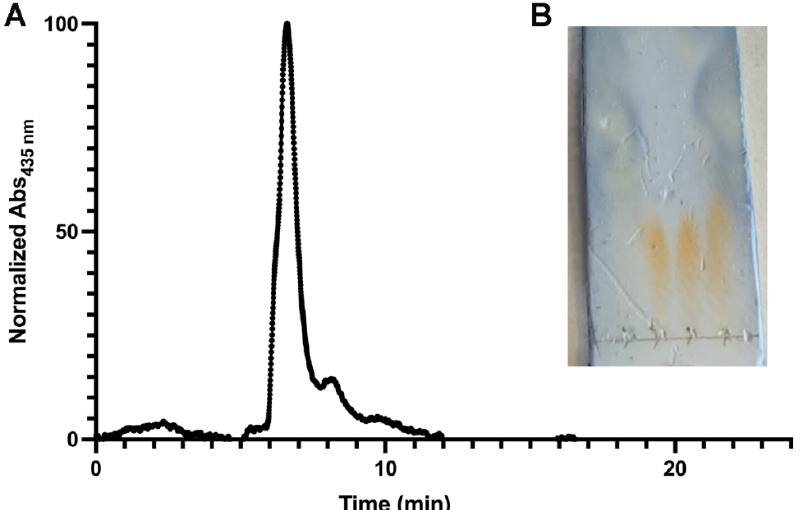
Figure 3. HSC lacks a chromophore, making chromatographic fractions hard to assay. ( A ) Chelation with Fe 3+ results in a chromophore absorbing at 435 nm, which runs over a reverse phase column in a single peak at 6.6 min. The shoulder at 7.9 min is likely underchelated Fe 3+ (2:1 or 1:1 ratio). The trace is normalized to the 6.6 min peak. ( B ) A typical TLC photo with CAM staining shows lanes 1 and 5 with higher R f impurities and splotchy staining; lanes 2, 3, and 4 contain HSC as dark orange.